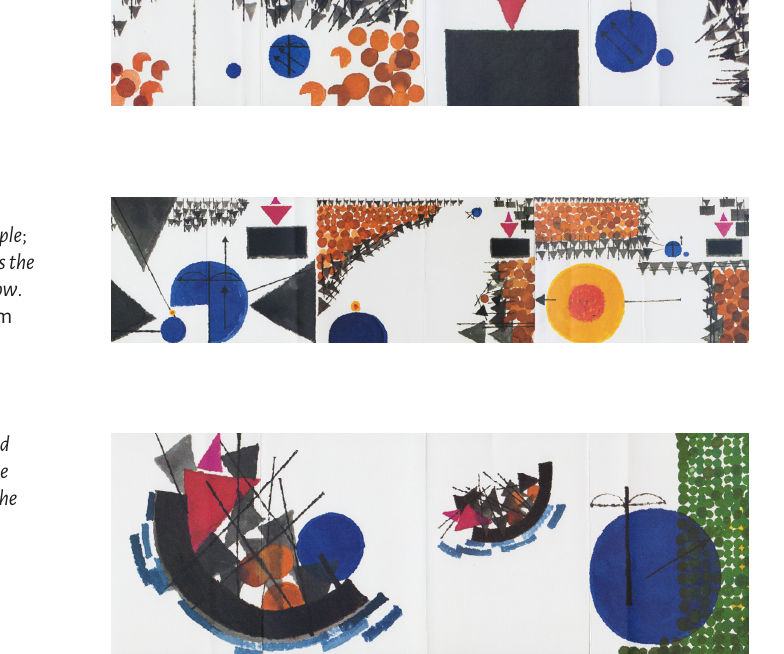
Fig. 9 Warja Lavater, Tell and son refuse to kneel ; Tell justifies his action . Warja Lavater (1962). Wilhelm Tell. Basel: Basilius Presse.